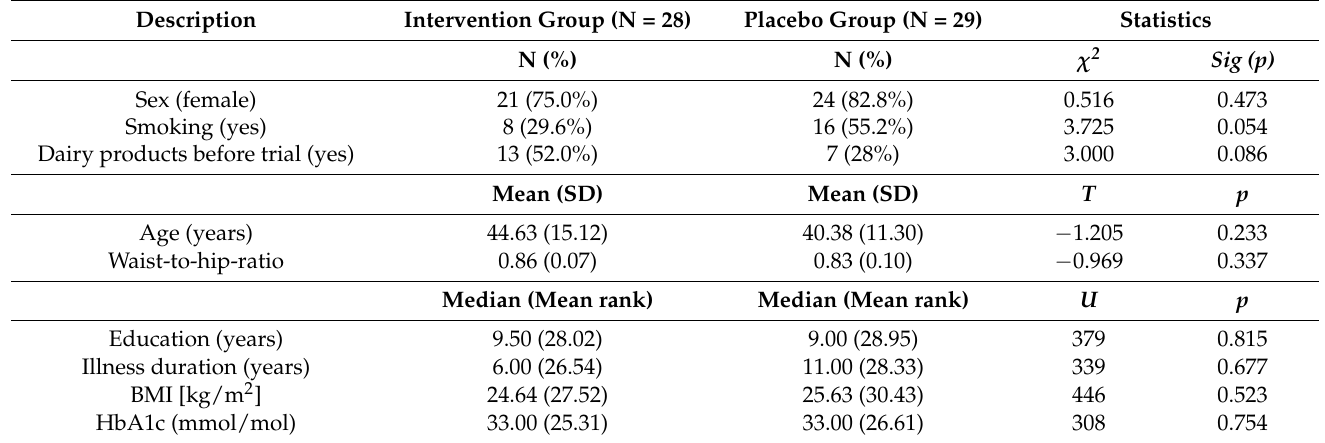
Table 1. Description of the PROVIT metabolomics sample at